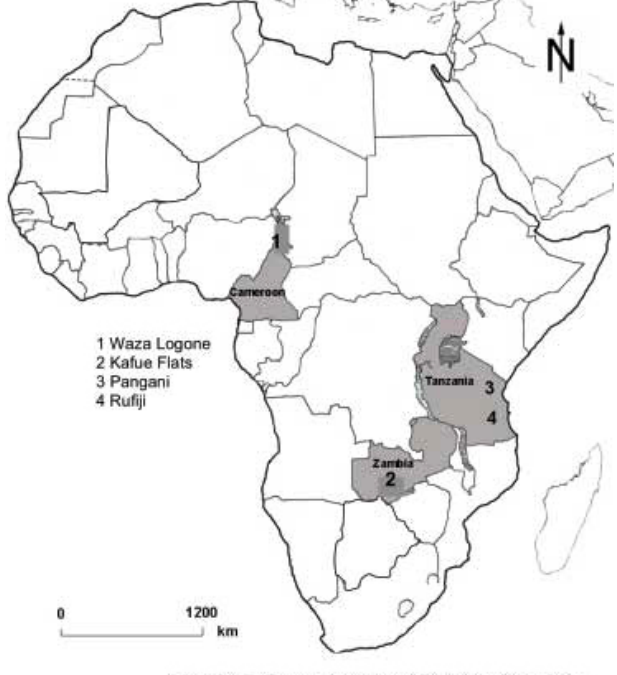
Fig. 1 . Map: Location of studied